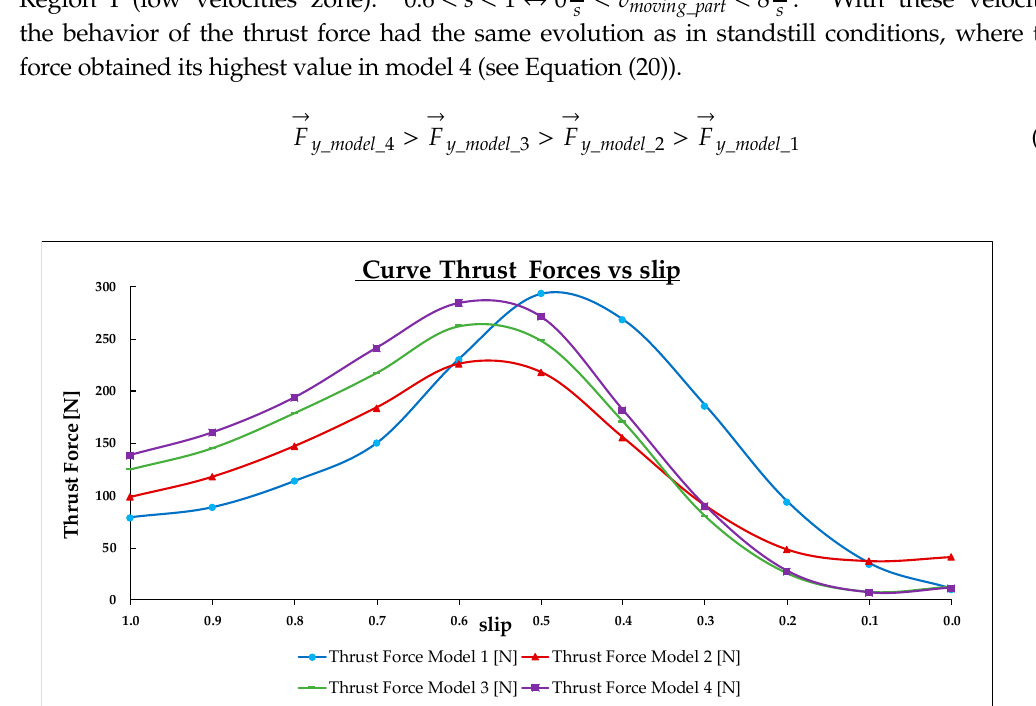
Figure 30. Thrust force versus slips.